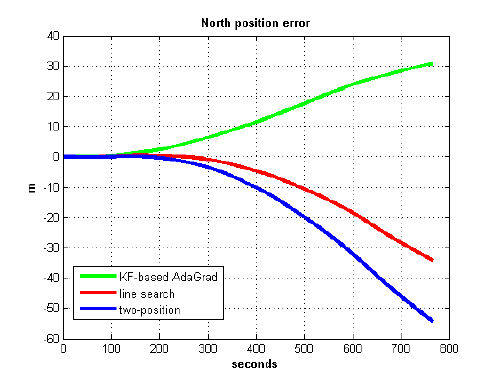
Figure 24. North position error in test 2.